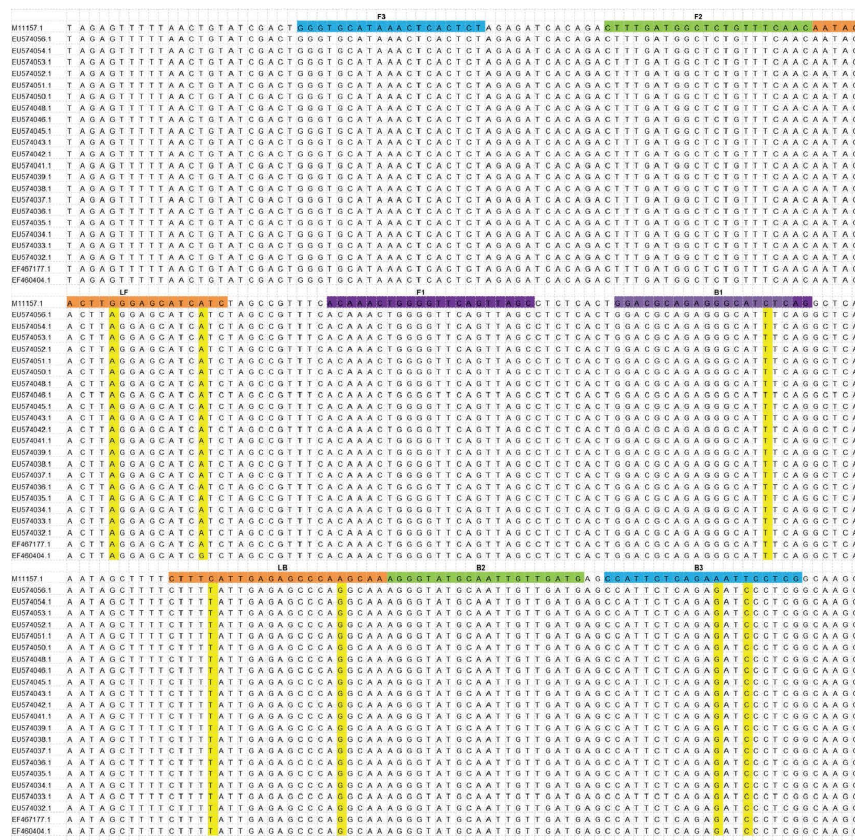
Figure 1: Position of RVFV RT-LAMP assay primers after alignment of RVFV M segment using MEGA 11 version 11.0.11